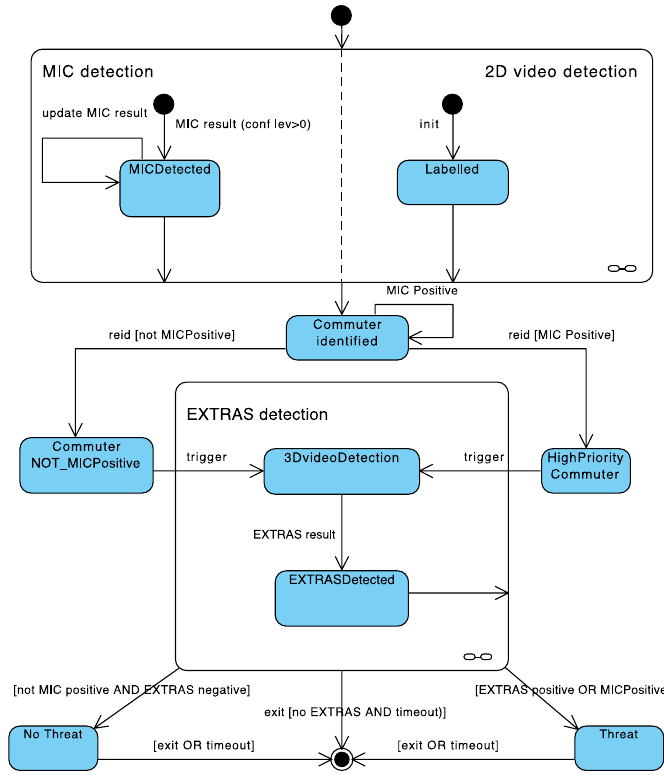
Figure 8. State-chart specification of the data fusion Figure 8. State ‐ chart specification of the data fusion method.